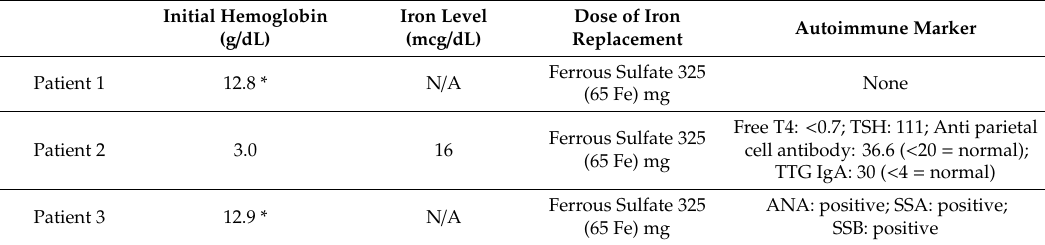
Table 2. Initial presenting labs of the three patients found to have Plummer-Vinson syndrome (PVS) and the dose of iron replacement they were started